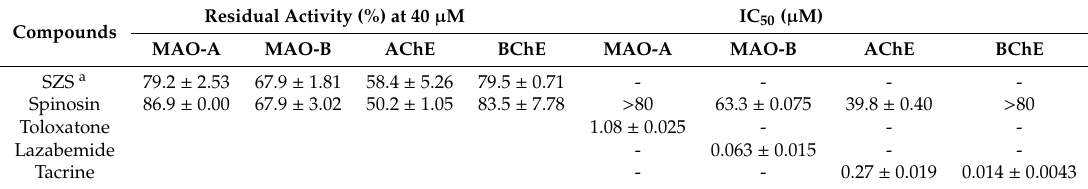
Table 1. Inhibitions of recombinant human monoamine oxidase (MAO) enzymes, acetylcholinesterase (AChE), and butyrylcholinesterase (BChE) by Semen Ziziphi Spinosae (SZS) extract and spinosin. Residual Activity (%) at 40 µ M Compounds